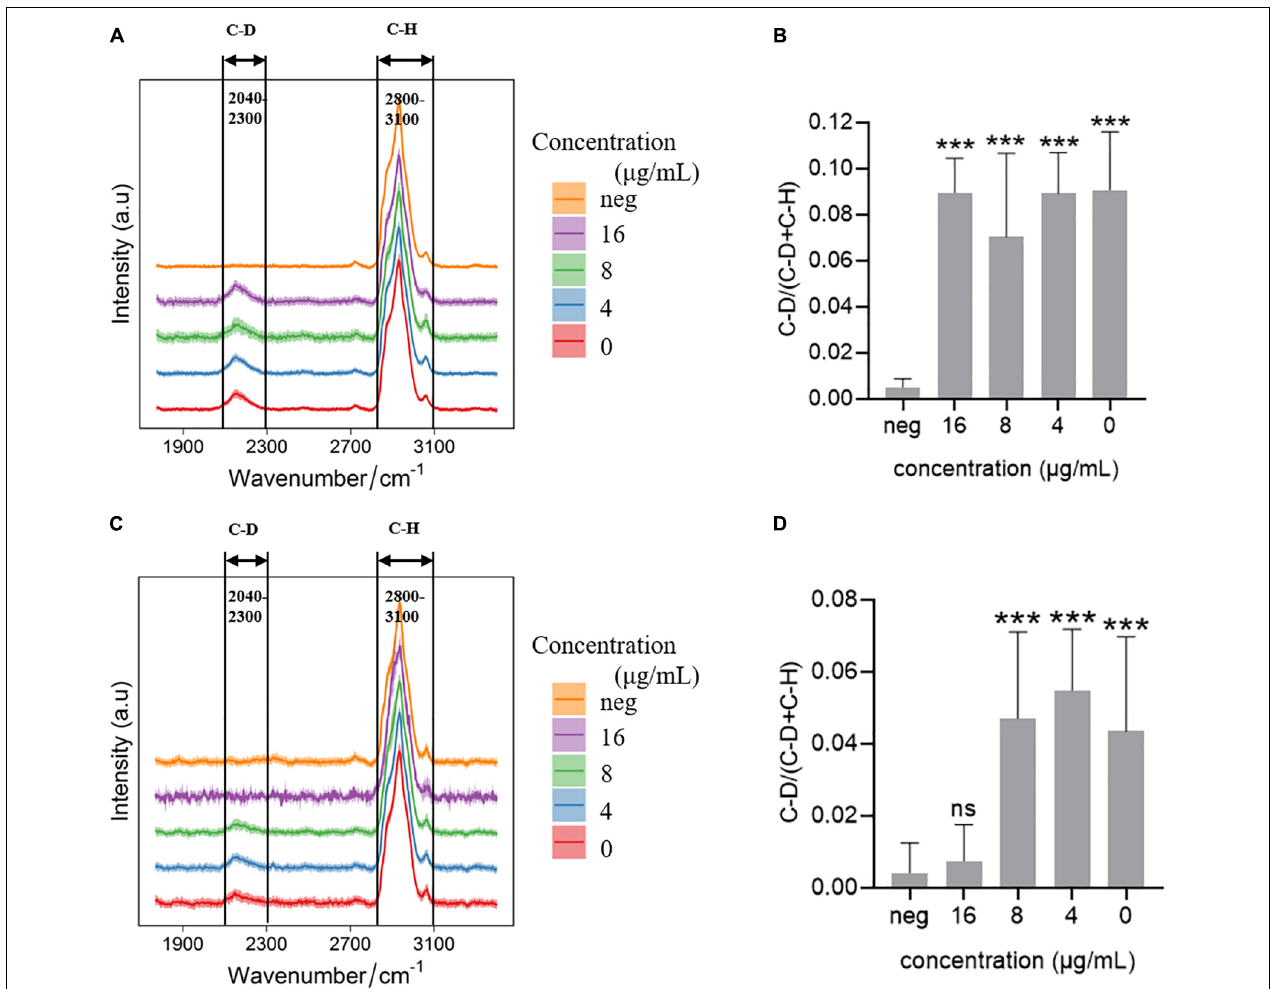
FIGURE 1 | Raman spectra of cells treated with imipenem (A) C-D and C-H band in FMS-007; (B) the C-D ratio of spectra in (A) ; (C) C-D and C-H band in TZ-3; (D) the C-D ratio of spectra in (C) ; and neg: without D 2 O and imipenem. Data were shown as mean ± SEM of neg and the other four group. *** P < 0.001; ns, no